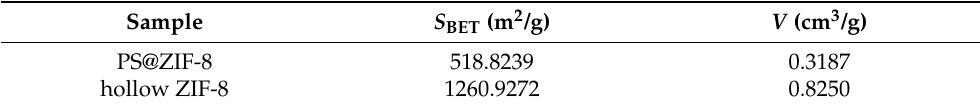
Figure 4. N 2 adsorption − desorption isotherms of PS@ZIF ‐ 8 and hollow ZIF ‐ 8 particles ( a ) with the corresponding pore size distribution ( b ). Table 1. Physical characterizations of PS@ZIF ‐ 8 and hollow ZIF ‐ 8 nanoparticles.